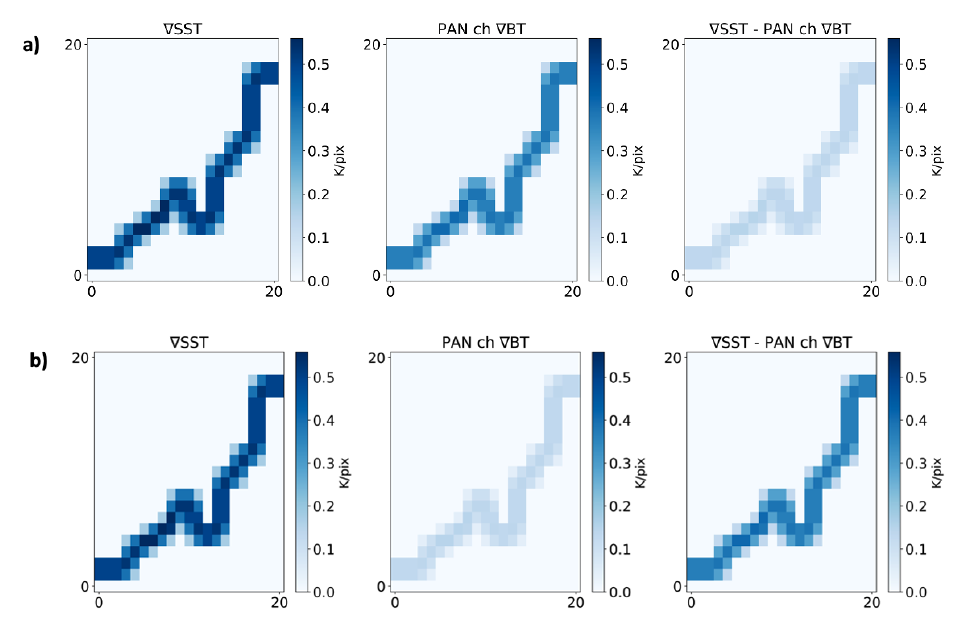
Figure 9. SST- and PAN-BT-derived gradient ( K · pixel − 1 ) comparison for subarctic winter ( a ) and tropical ( b ) cases. From left to right: SST gradient, BT gradient and the difference of the two fields.